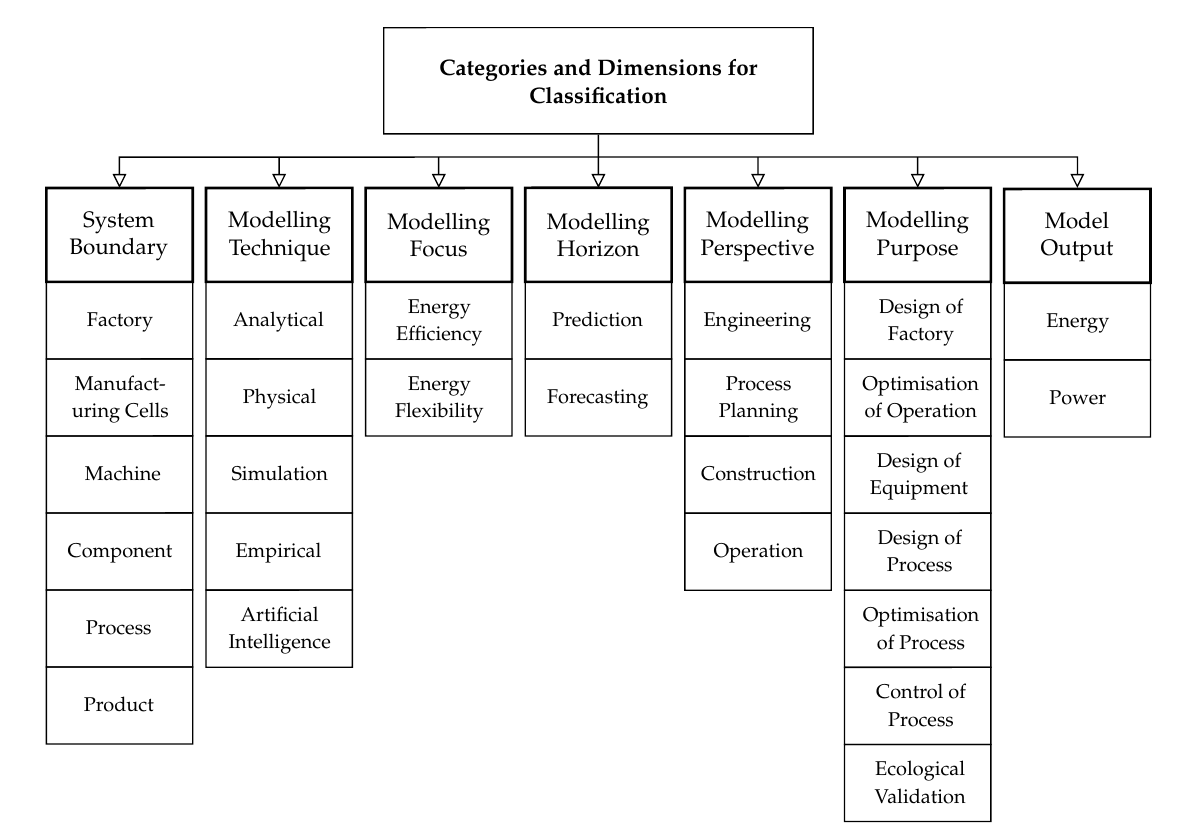
Figure 2. Dimensions for classifying work in the field of energy modelling.